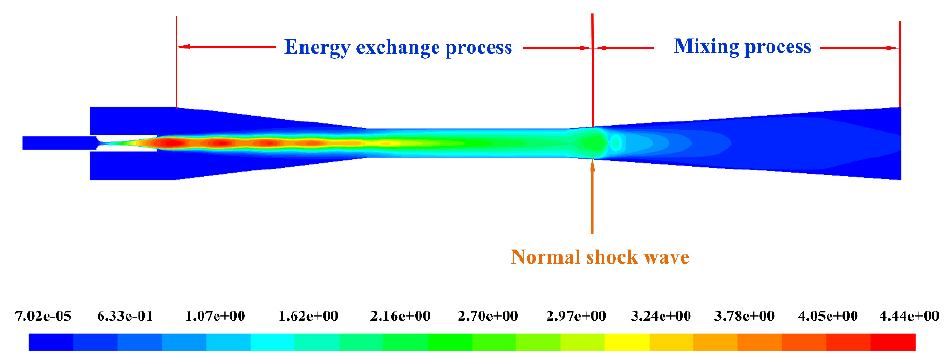
Figure 8. Flow structure partition under the influence of the shock-mixing layer.